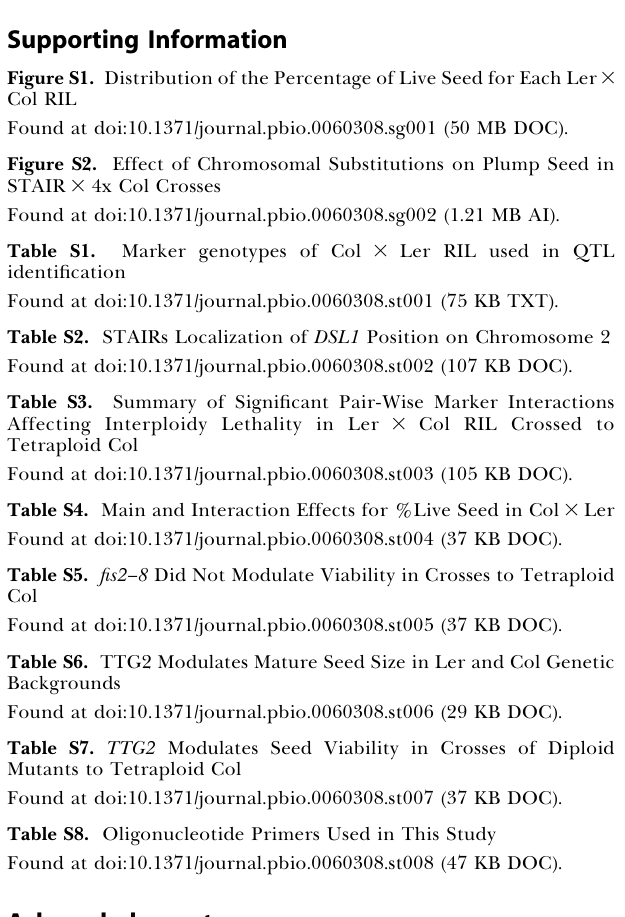
Figure S1. Distribution of the Percentage of Live Seed for Each Ler 3 Col RIL Found at doi:10.1371/journal.pbio.0060308.sg001 (50 MB DOC). Figure S2. Effect of Chromosomal Substitutions on Plump Seed in STAIR 3 4x Col Crosses Found at doi:10.1371/journal.pbio.0060308.sg002 (1.21 MB AI). Marker genotypes of Col 3 Ler RIL used in QTL identification Found at doi:10.1371/journal.pbio.0060308.st001 (75 KB TXT). Table S2. STAIRs Localization of DSL1 Position on Chromosome 2 Found at doi:10.1371/journal.pbio.0060308.st002 (107 KB DOC). Table S3. Summary of Significant Pair-Wise Marker Interactions Affecting Interploidy Lethality in Ler 3 Col RIL Crossed to Tetraploid Col Found at doi:10.1371/journal.pbio.0060308.st003 (105 KB DOC). Table S4. Main and Interaction Effects for %Live Seed in Col 3 Ler Found at doi:10.1371/journal.pbio.0060308.st004 (37 KB DOC). Table S5. fis2–8 Did Not Modulate Viability in Crosses to Tetraploid Col Found at doi:10.1371/journal.pbio.0060308.st005 (37 KB DOC). Table S6. TTG2 Modulates Mature Seed Size in Ler and Col Genetic Backgrounds Found at doi:10.1371/journal.pbio.0060308.st006 (29 KB DOC). Table S7. TTG2 Modulates Seed Viability in Crosses of Diploid Mutants to Tetraploid Col Found at doi:10.1371/journal.pbio.0060308.st007 (37 KB DOC). Table S8. Oligonucleotide Primers Used in This Study Found at doi:10.1371/journal.pbio.0060308.st008 (47 KB